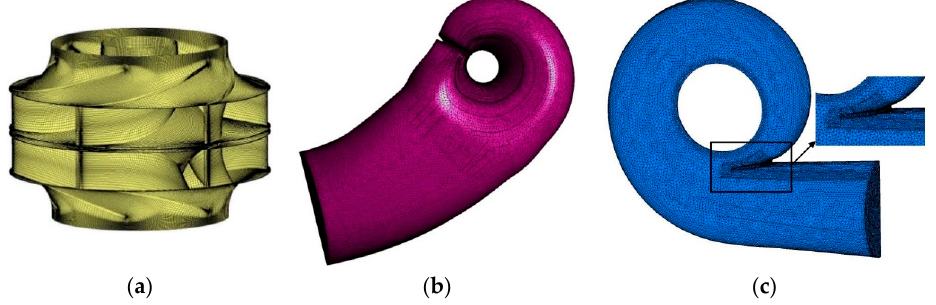
Figure 3. Mesh of different parts in pump. ( a ) Impellers mesh of case0; ( b ) Suction mesh; ( c ) Volute mesh.